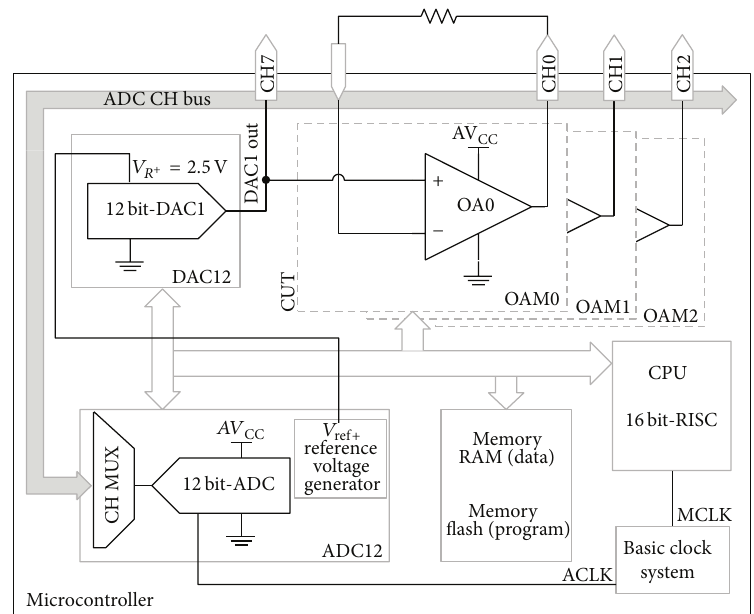
Figure 7: Arrangement for testing mode